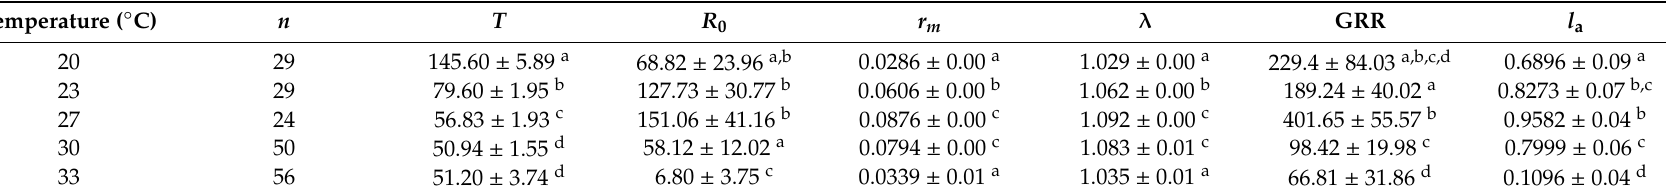
Table 3. Population parameters (T, mean generation time [d]; R0, net reproduction rate [o ff spring / individual]; r m , intrinsic rate of natural increase [d-1]; λ , finite rate of increase [d-1]; GRR, gross reproduction rate [o ff spring / individual] and l a , pre-adult survival rate [%]) of H. halys (mean ± SE) as a ff ected by temperature ( ◦